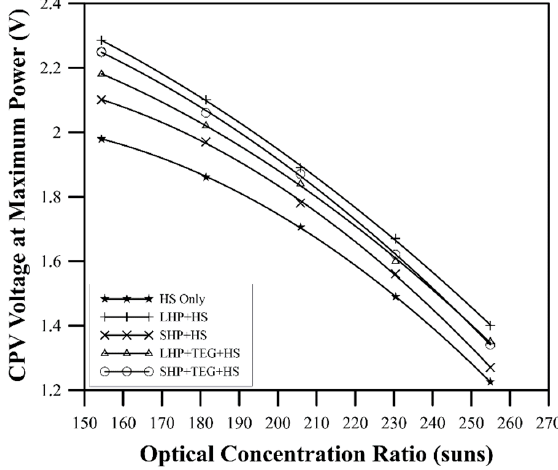
Figure 5. Decrease of the CPV voltage at maximum power as a function of the optical concentration ratio.